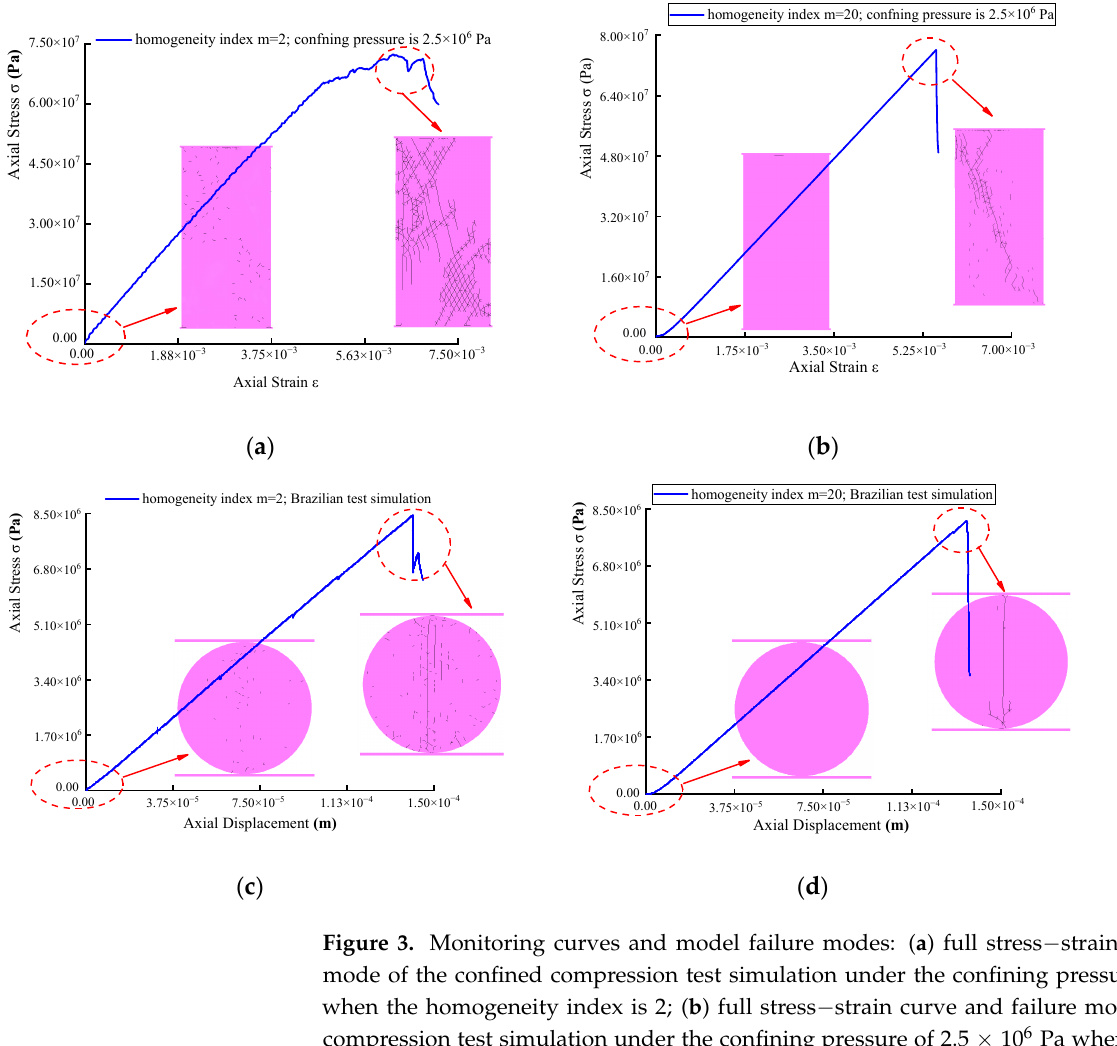
Figure 3. Monitoring curves and model failure modes: ( a ) full stress − strain curve and failure mode of the confined compression test simulation under the confining pressure of 2.5 × 10 6 Pa when the homogeneity index is 2; ( b ) full stress − strain curve and failure mode of the confined compression test simulation under the confining pressure of 2.5 × 10 6 Pa when the homogeneity index is 20; ( c ) displacement − stress curve and failure mode of the Brazilian test simulation when the homogeneity index is 2; ( d ) displacement − stress curve and failure mode of the Brazilian test simulation when the homogeneity index is 20.